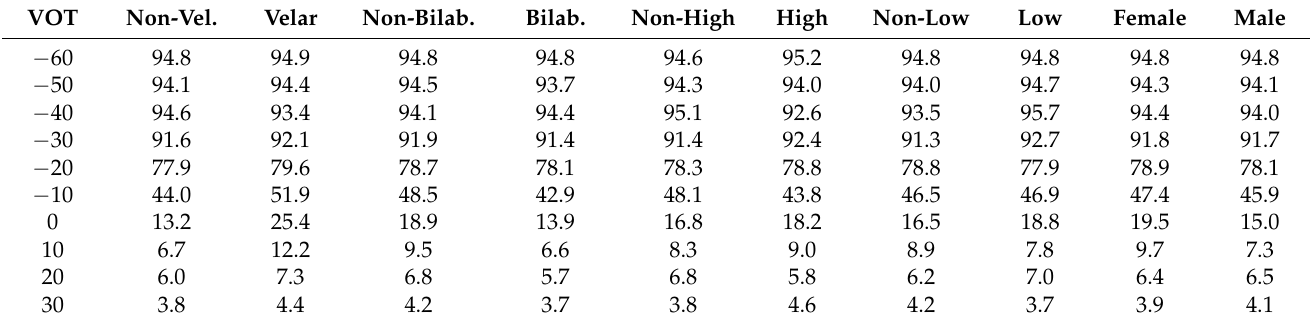
Table A2. Mean rates of ‘voiced’ responses (%) across 10 VOT levels (Experiment 1, original voice tokens). VOT Non-Vel.